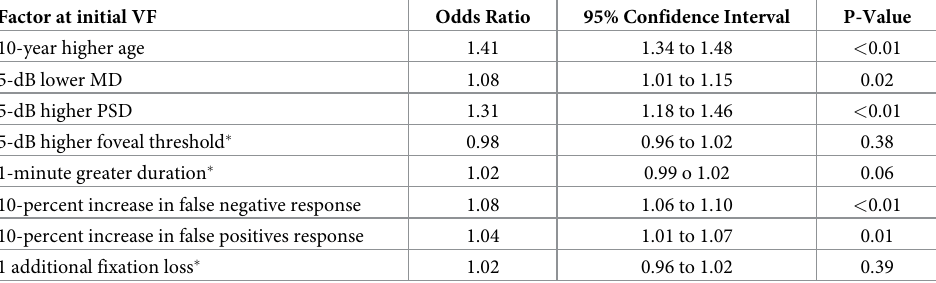
Table 4. Factors that influence the odds of being labeled a rapid progressor based on output from the logistic regression